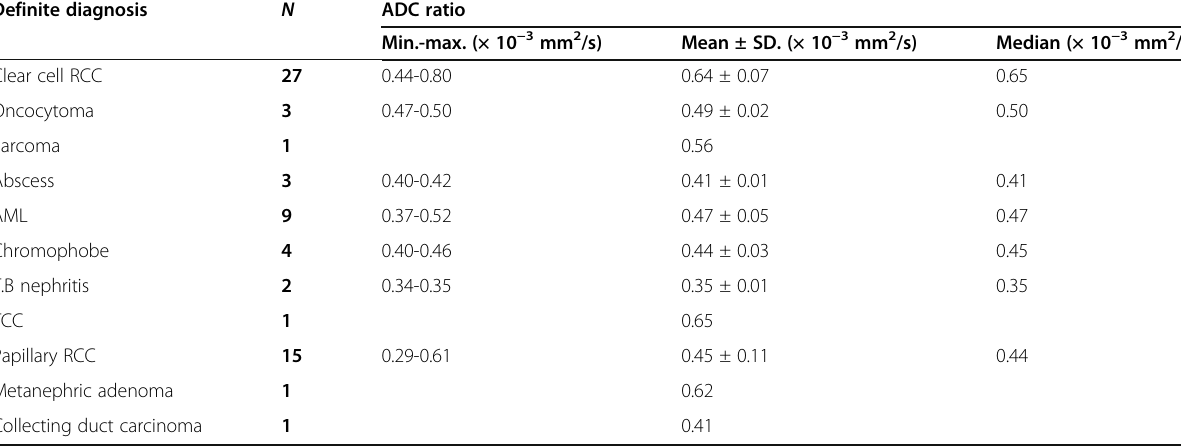
Table 3 Min., max., mean, and median ADC ratio for different masses ( n = 67) Definite